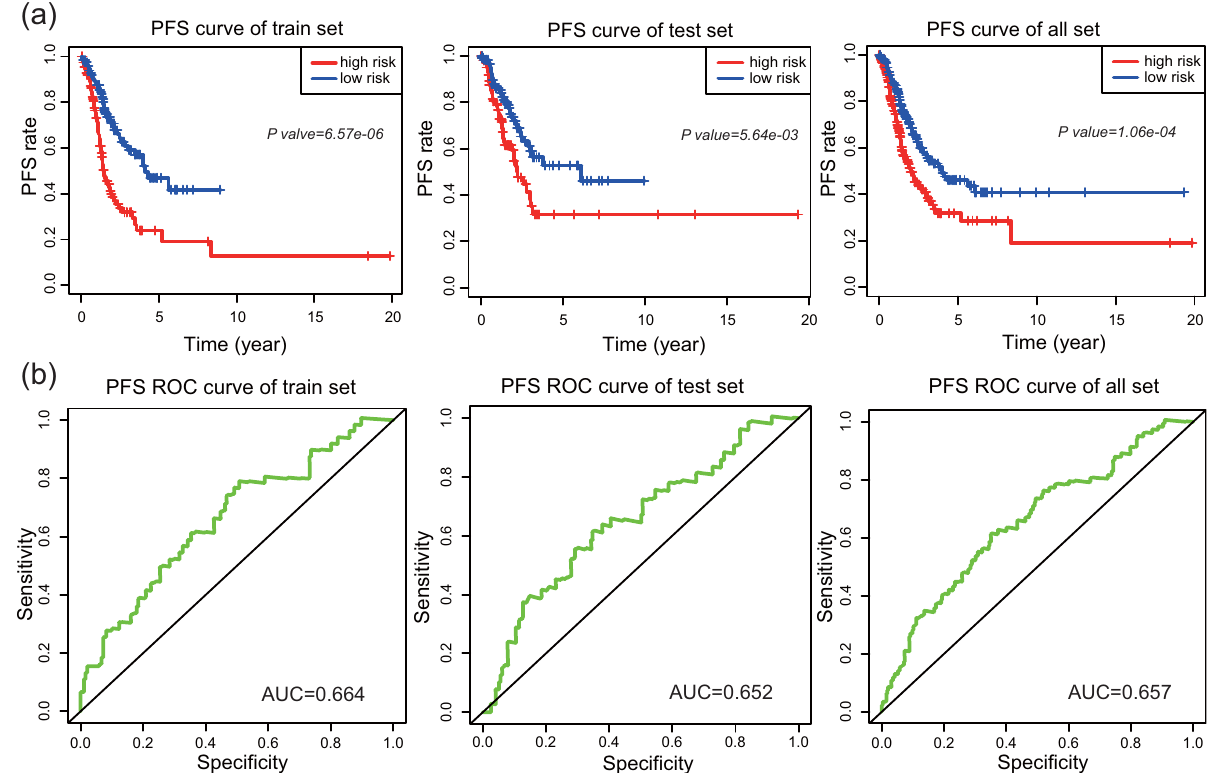
Figure 4: PFS analysis of the four - lncRNA signature. ( a ) The Kaplan – Meier curve of PFS. ( b ) The ROC curve of PFS in the training set, test set, and entire